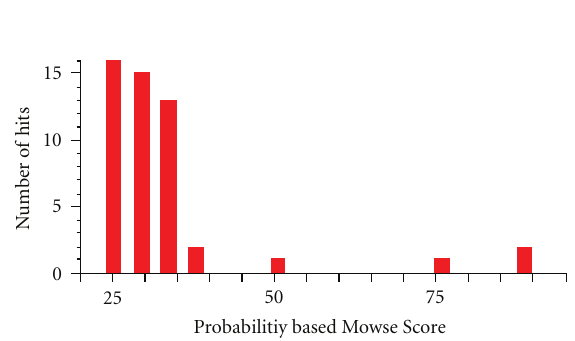
Figure 7: Mascot search results of protein spot 8 are Haptoglobin. Mowse Score was 89 ( > 58, P < . 05). When the figure was at the margin of shadow, Mowse Score was 58 and P = . 05. If the score was more than 58, P < . 05.